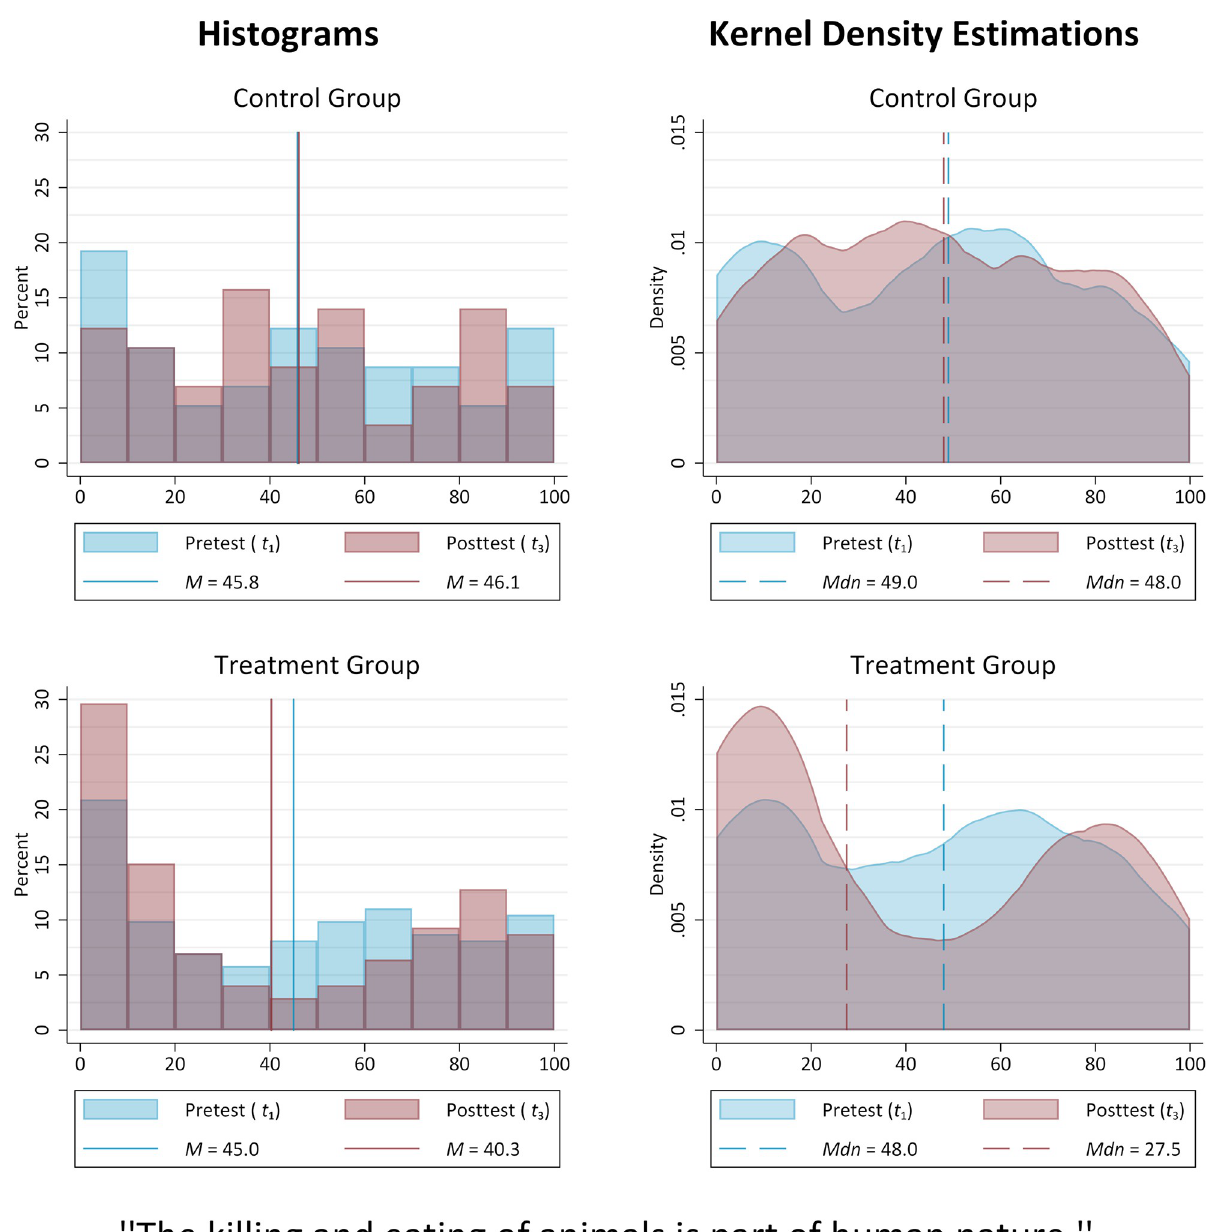
Fig 2. Target item distributions (control vs. treatment group). S OURCE : ODSF2018 (https://doi.org/10.6084/m9.figshare.16595378.v1), own calculations.